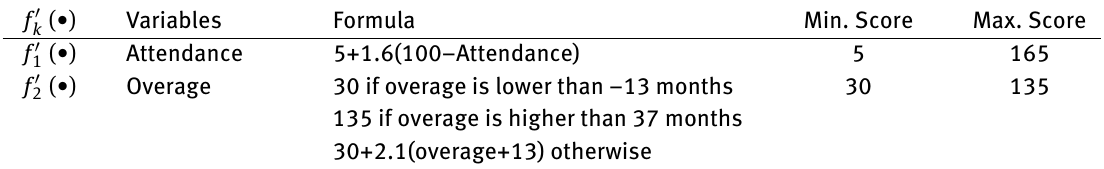
Figure 1: Observed IVSE Density and Hypothetical IVSE Density (Year 2014) (•) Transforming IVSE Variables into Scores Table 6: Functions f ′ k